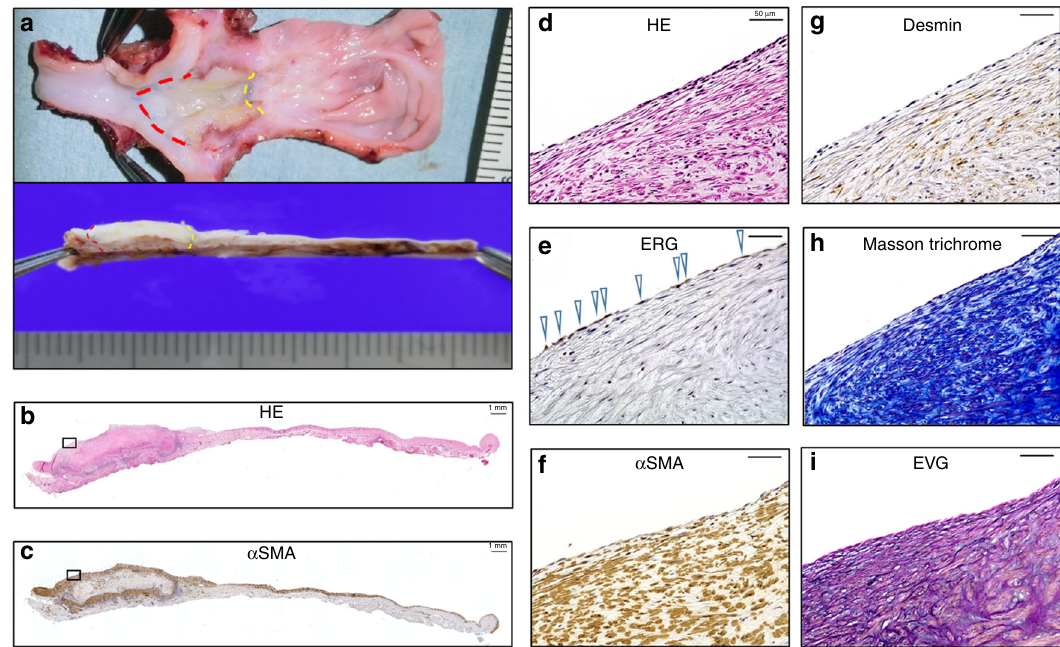
Fig. 6 The histological analysis of the HOBPT at 3 months after transplantation in OIDPs. The graft was opened longitudinally with the proximal artery and distal vein. The red dotted line indicates the junction of the artery and graft, and the yellow dotted line indicates that of the graft and vein. The luminal surface of the HOBPT was whitish, smooth, and contiguous from the surface of the recipient ’ s common carotid artery and vein without thrombus a . Microscopically, the luminal surface was lined with an ERG-positive monolayer of endothelial cells b , d , e . Host-derived alpha-SMA and desmin-positive smooth muscle cells migrated into the HOBPT wall from the upper, lower and lateral margins b , c , f , g . Elastica van Gieson staining showed “ neomedia ” beneath the luminal surface i in the collagenous extracellular matrix and stained blue by Masson – trichrome staining h . Scale bar: 1 mm in b , c , 50 µ m in d – i . HOBPT: